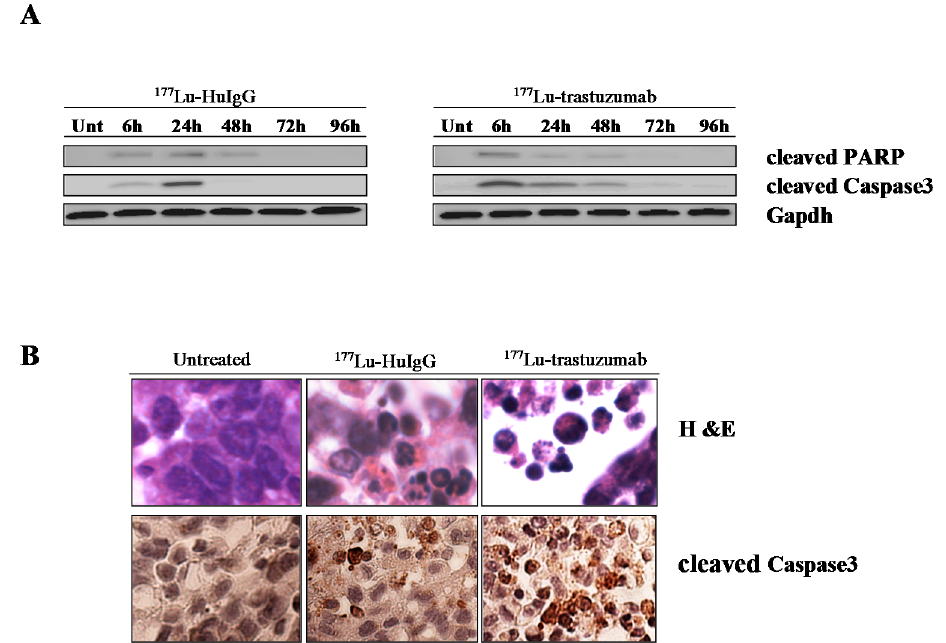
Figure 1. Induction of apoptosis in human colon cancer LS-174T intraperitoneal (i.p.) xenografts following 177 Lu-trastuzumab treatment. ( A ) Tumor bearing mice were treated with 177 Lu-trastuzumab and the tumor tissue was collected at the indicated times. Additional groups included 177 Lu-HuIgG as a non-specific control and untreated mice. Immunoblot analysis for caspase-3 and PARP was conducted and both cleaved caspase-3 (17 kDa) and PARP (89 kDa) were observed. The equivalent protein loading control was GAPDH; ( B ) Apoptosis induced by 177 Lu-trastuzumab. Tumor bearing mice were treated with 177 Lu-trastuzumab. Additional groups included 177 Lu-HuIgG as a non-specific control and untreated mice. Paraffin-embedded sections were stained with haamatoxylin and eosin (H & E) or cleaved caspase-3 antibody under light microscopy (40× magnification).